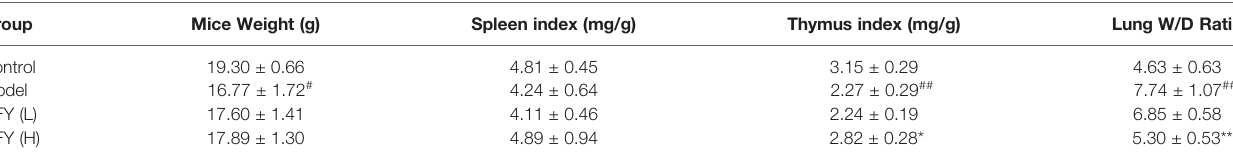
TABLE 1 | Measurement of visceral